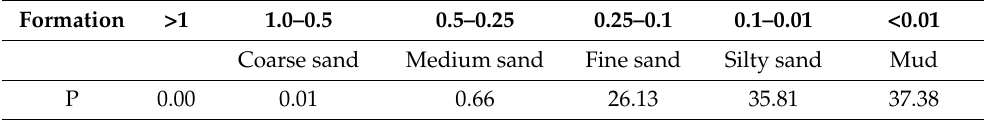
Table 2. Grain size analysis results of P